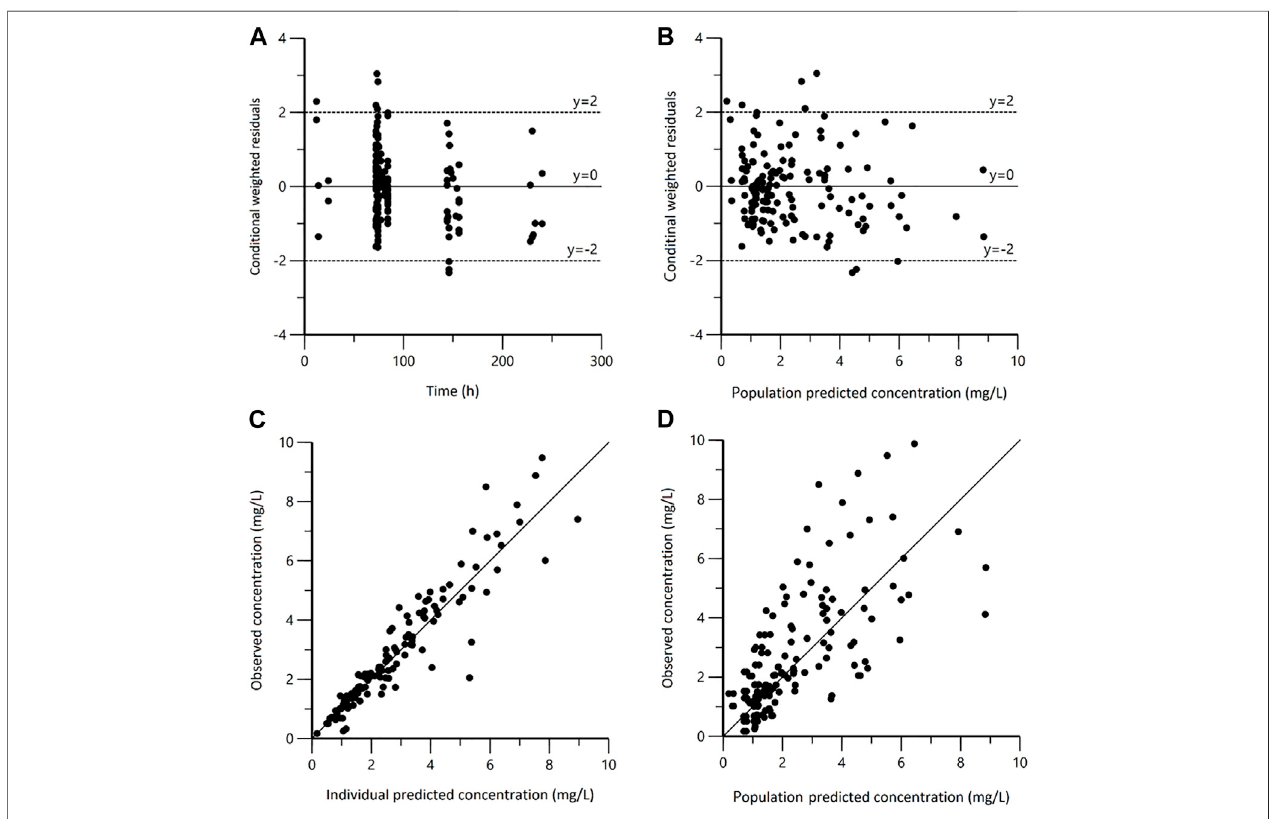
FIGURE 2 | Goodness-of- fi t plots for the fi nal population pharmacokinetic model. (A) Conditional weighted residuals versus time (CWRES vs. IVAR); (B) Conditional weighted residuals versus population predicted concentrations (CWRES vs. PRED); (C) Observed versus individual predicted concentrations (DV vs. IPRED); (D) Observed versus population predicted concentrations (DV vs.